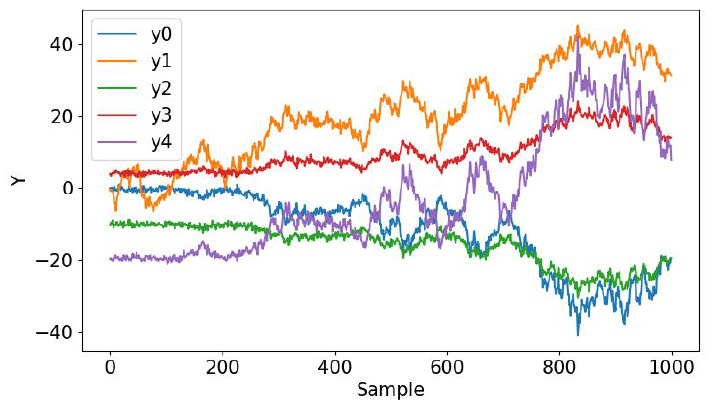
Figure 6. Training data sample.